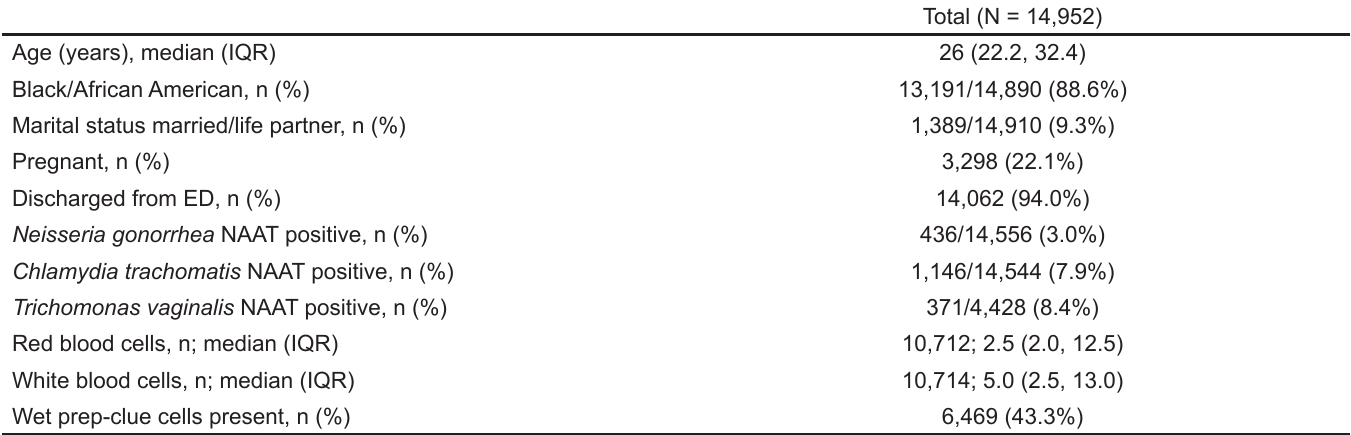
Table 1. Encounter characteristics.